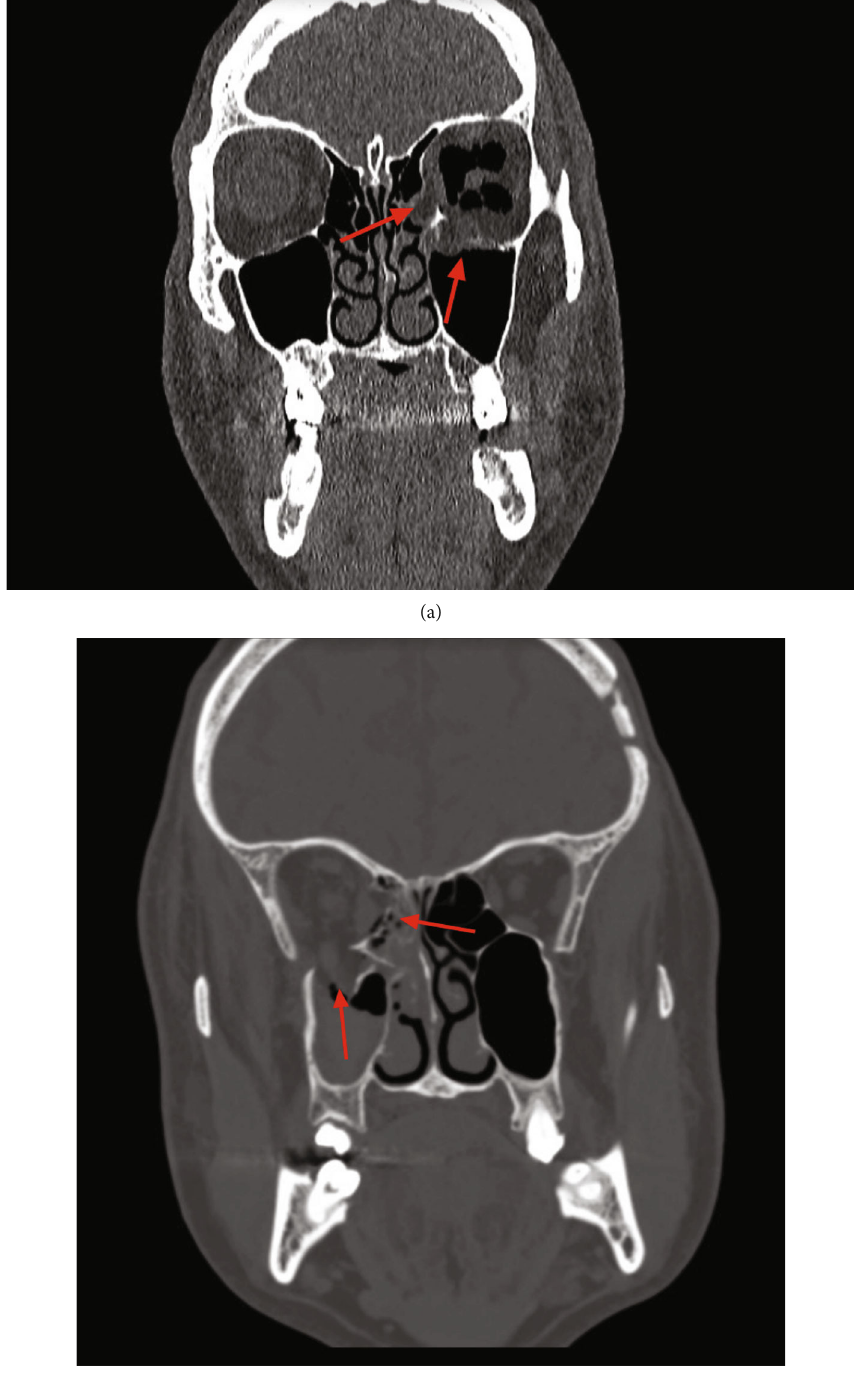
Figure 10: Exemplary CT scan analysis; red arrows indicate observed orbital wall fractures. (a) Male, 49, su ff ering both eyeball and orbital injury after boxing training with multifracture of the medial and lower walls of the left orbit. Bone fragment dislocated into maxillary and ethmoidal sinuses. (b) Male, 59, a fi ght victim su ff ering multifracture orbital trauma including both medial and lower walls of the right orbit with translocation of the bone fragment into maxillary and ethmoidal sinuses. Clinically diagnosed diplopia and damage of maxillary nerve (CN V 2